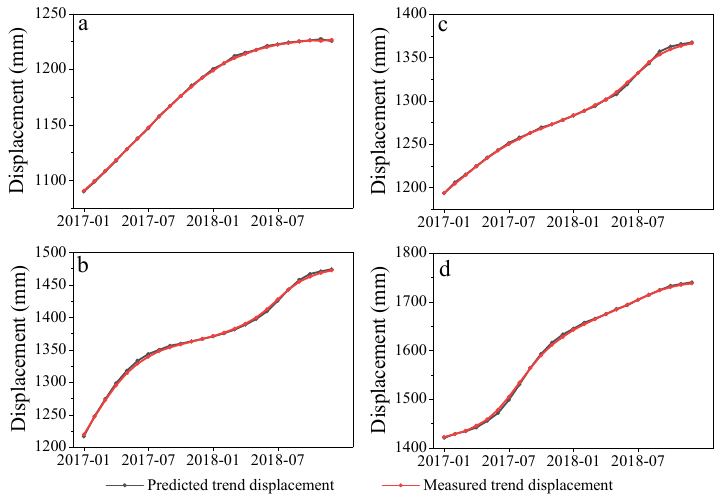
Table 3. The predicted accuracy for the training models.